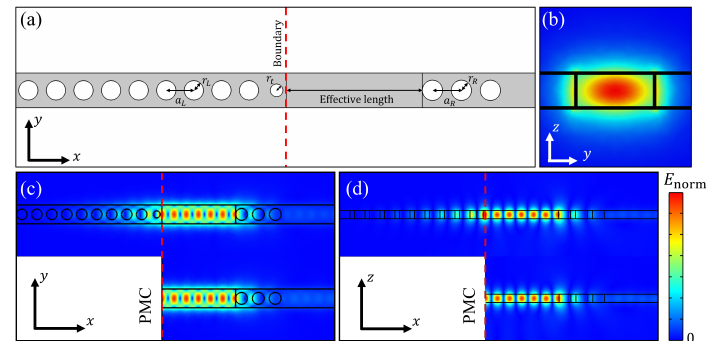
Figure 2. ( a ) Simulation configuration for resonance mode. PC nanobeam resonator consists of nanobeam with 500 nm of width and air holes. The defect in PC nanobeam acts as a simple Fabry– Perot resonator. The role of air holes is PMC-like boundary at left side of resonator and coupler at right side of resonator respectively. Red dashed line is boundary of resonator when PMC and PMC-like boundaries are applied. a L and a R are lattice constants of PC at left side and right side of resonator and r L and r R are radii of holes at left side and right side of resonator, and r t is the radius of tapered hole. ( b ) Cross-sectional view of E norm of wave propagation in waveguide. Norm of the electric field distributions in the nanobeam for the PMC-like (top) and PMC (bottom) boundaries in xy -plane ( c ) and xz -plane ( d ), respectively. The lattice constants of the PC on the left and right sides of the resonator were 400 and 450 nm, respectively, and the hole size of each PC was r / a =